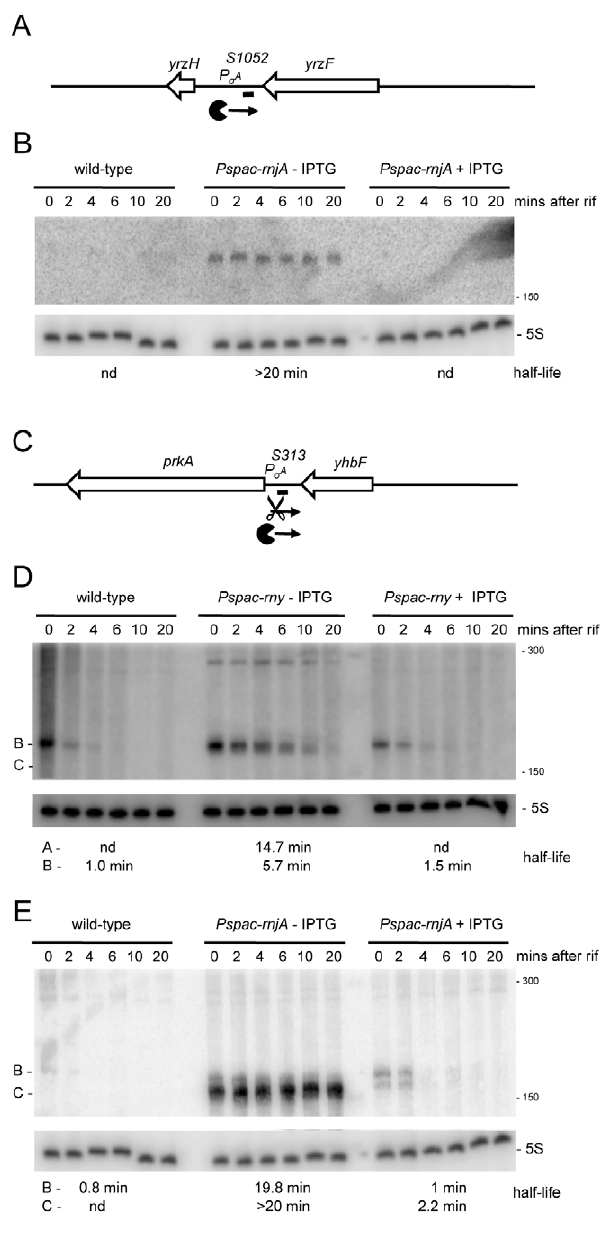
Figure 8. Detection of new potential regulatory RNAs in RNase Y and J1 mutants. (A) Structure and predicted degradation pathways of the S1052 RNA. ORFs are shown as large white arrows, transcripts as thin black arrows. ‘Pacman’ symbol represents 5 9 -3 9 degradation by RNase J1. A short thick line indicates the position of the probe used. P s A indicates the putative promoter and sigma factor for the regulatory RNA predicted by the DBTBS website (http://dbtbs.hgc.jp/) and in agreement with the size detected by Northern blot. (B) Northern blot of total mRNA isolated at times after addition of rifampicin (rif) from wild- type and RNase J1 depleted ( Pspac-rnjA 2 IPTG) and RNase J1 induced ( Pspac-rnjA + IPTG) cells. The blot was probed with 5 9 -labeled oligo CCB852 (Table S6) and reprobed with oligo HP246 against 5S rRNA. The half-life of the S1052 transcript is given under the Northern blot (nd is not detected). Migration positions of RNA markers are shown to the right of the blot. (C) Structure and predicted degradation pathway of the S313 RNA. Features as in panel (A); scissors indicate cleavage by RNase Y. (D) Northern blot of total mRNA isolated at times after addition of rifampicin (rif) from wild-type and RNase Y depleted ( Pspac- rny 2 IPTG) and RNase Y induced ( Pspac-rny + IPTG) cells. The half-lives